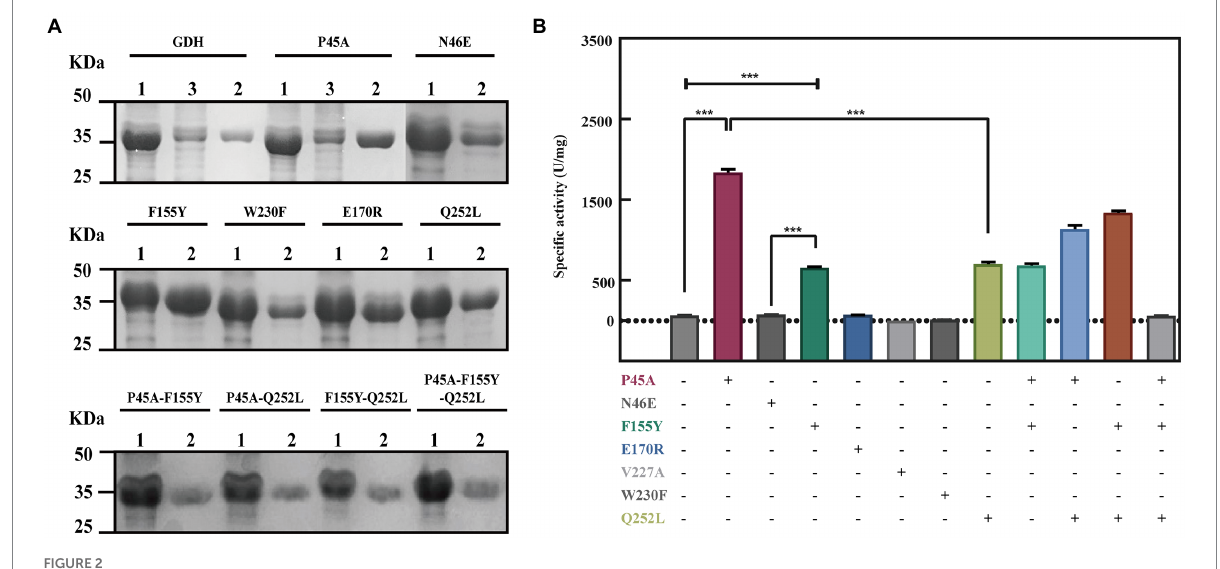
FIGURE 2 Improvement of the GDH catalytic ability by site-directed mutagenesis. (A) SDS polyacrylamide gel electrophoresis (SDS-PAGE) analysis of GDH mutants. Lane 1: crude enzyme solution; Lane 2: pure GDH mutants by Ni-NTA chromatography; Lane 3 flow-through of sample. 10 μ g protein was analyzed by SDS-PAGE using 12% polyacrylamide gel. Protein bands were stained by Coomassie Brilliant Blue R250. (B) Evaluation of the mutants by site-directed mutagenesis. The results are expressed as the mean ± SD (n = 3). * Indicates p < 0.05, ** indicates p < 0.01, and *** indicates p <